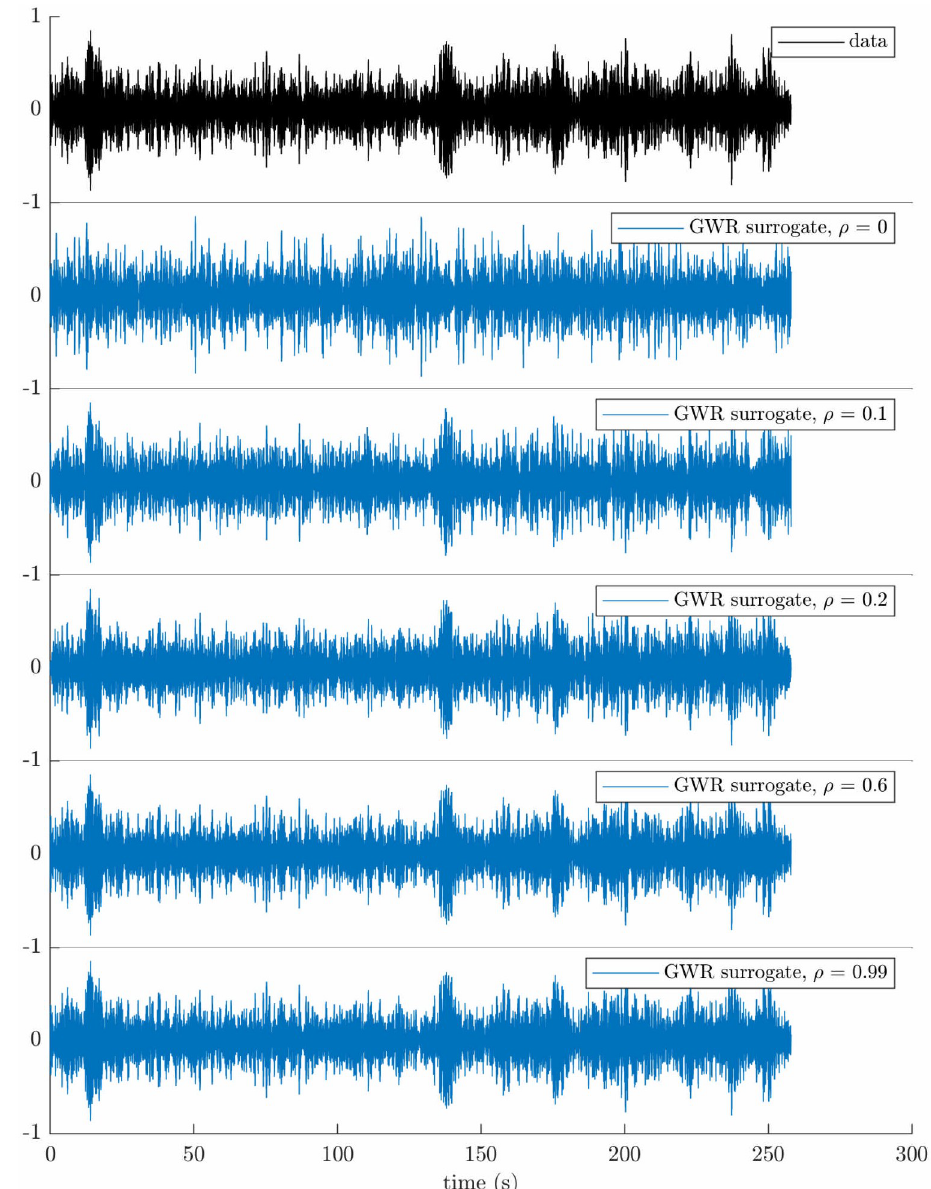
Fig 13. Filtered LFP for patient 6L OFF (black), and corresponding GWR surrogates for a range of ρ levels (blue). Most of the data temporal variability is already accounted for at ρ = 0.1. The plots share the same time